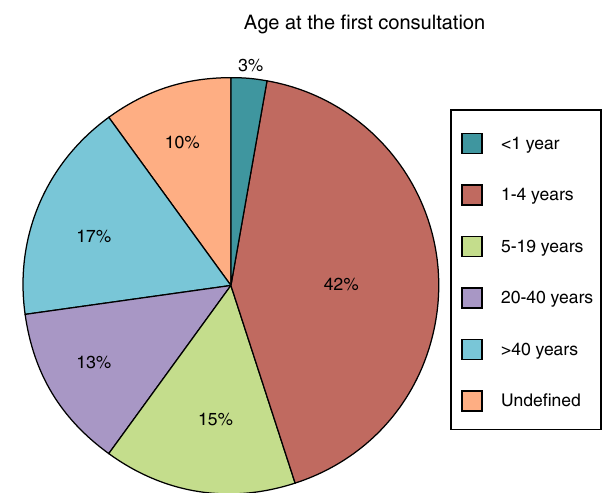
Figure 2 Percentage distribution of patients evaluated in the cochlear implant outpatient clinic according to age range at hearing loss diagnosis.